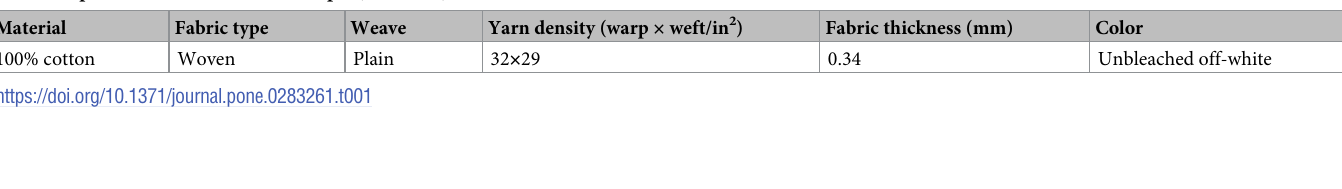
Table 1. Specifications of the fabric sample